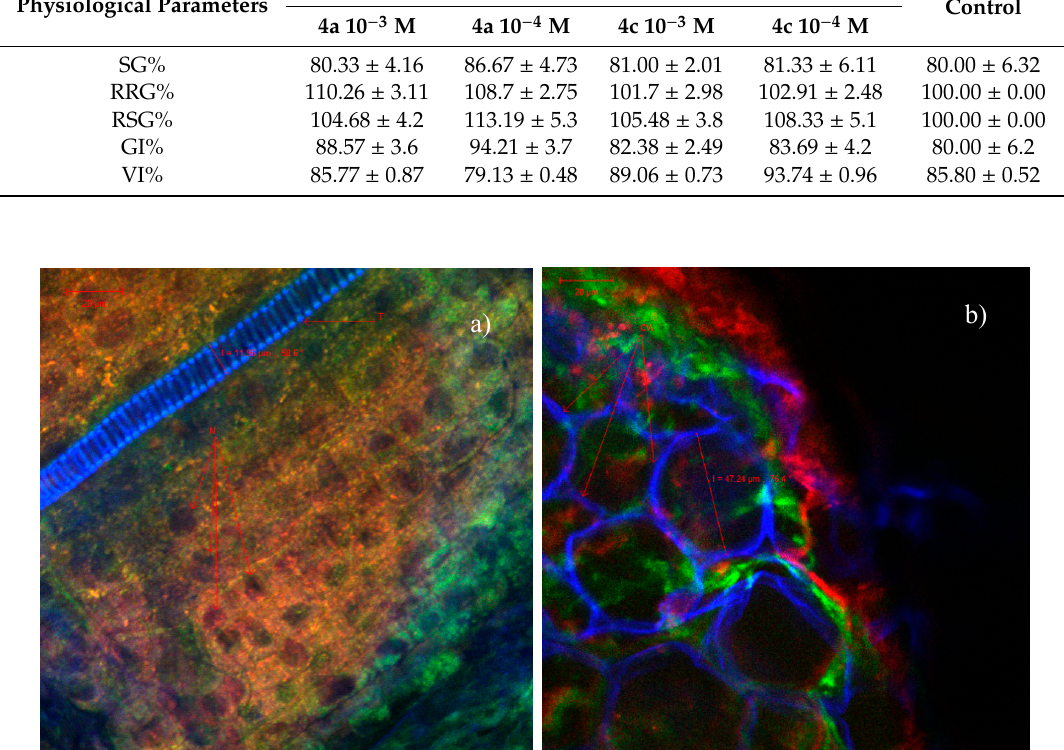
Figure 7. Confocal laser scanning microscopy (CLSM) images of the Triticum estivum L. sprout sections-control sample (germination in ultrapure water): ( a ) root, ( b ) shoot.